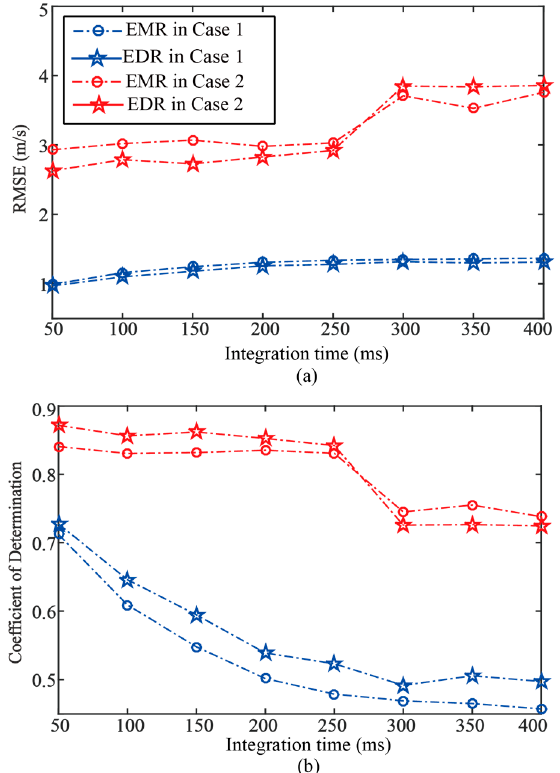
Figure 11. ( a ) RMSE and ( b ) coefficient of determination R 2 as a function of the coherent integration time. Case1 is the gentle wind scenario, Case 2 is in the UTOR scenario.